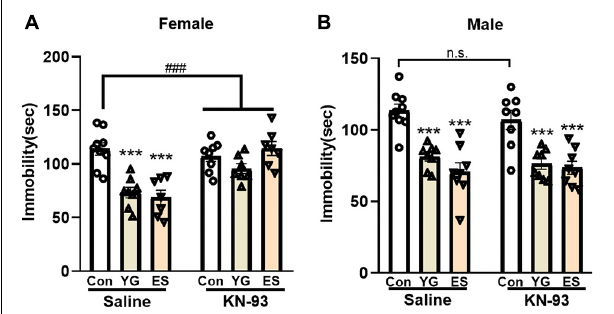
FIGURE 6 | The effect of pretreatment with saline or KN-93 on single YG (2.5g/kg) or ES (20mg/kg) administration during the TST paradigm in (A) female and (B) male mice. *** p < 0.001, compared with the control group of saline pretreatment, one-way ANOVA, n = 7-9/group. The interaction between saline and KN-93 pretreatment was analyzed by two-way ANOVA. ### p < 0.001 compared to non-LPS control